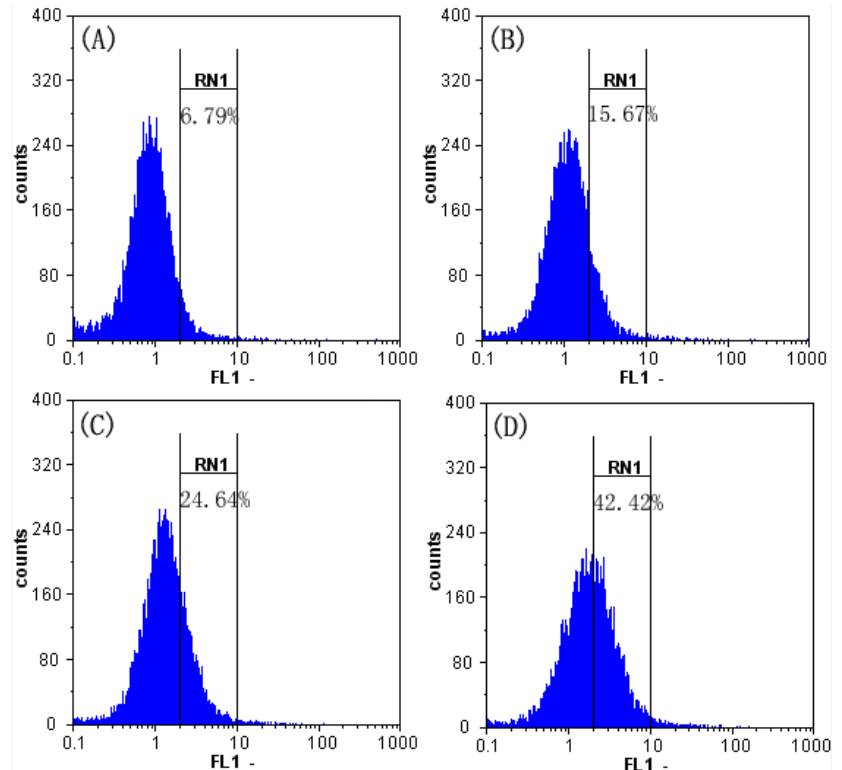
Figure 7. Effect of SFE-CO extract on intracellular calcium levels of SMMC-7721 cells 2 assayed by flow cytometry analysis of Fluo-3/AM stained cells. ( A ) Untreated control cells;